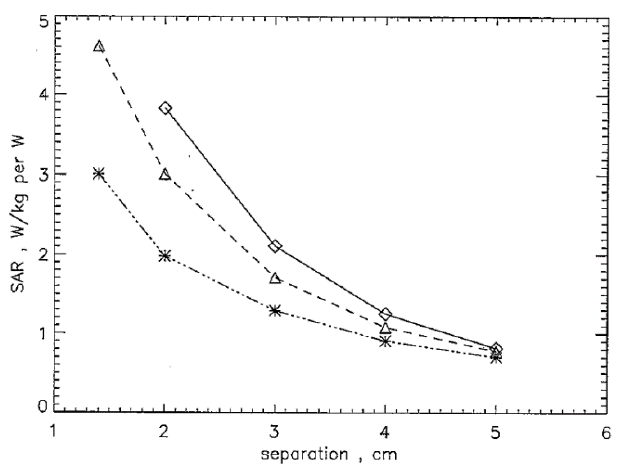
Figure 3. The envelope of maximum SAR averaged over 10 g at 1.8 GHz as a function of the separation of the centre of the transceiver from the head: AP v (diamonds), LAT v (triangles), and LAT h (asterisks).